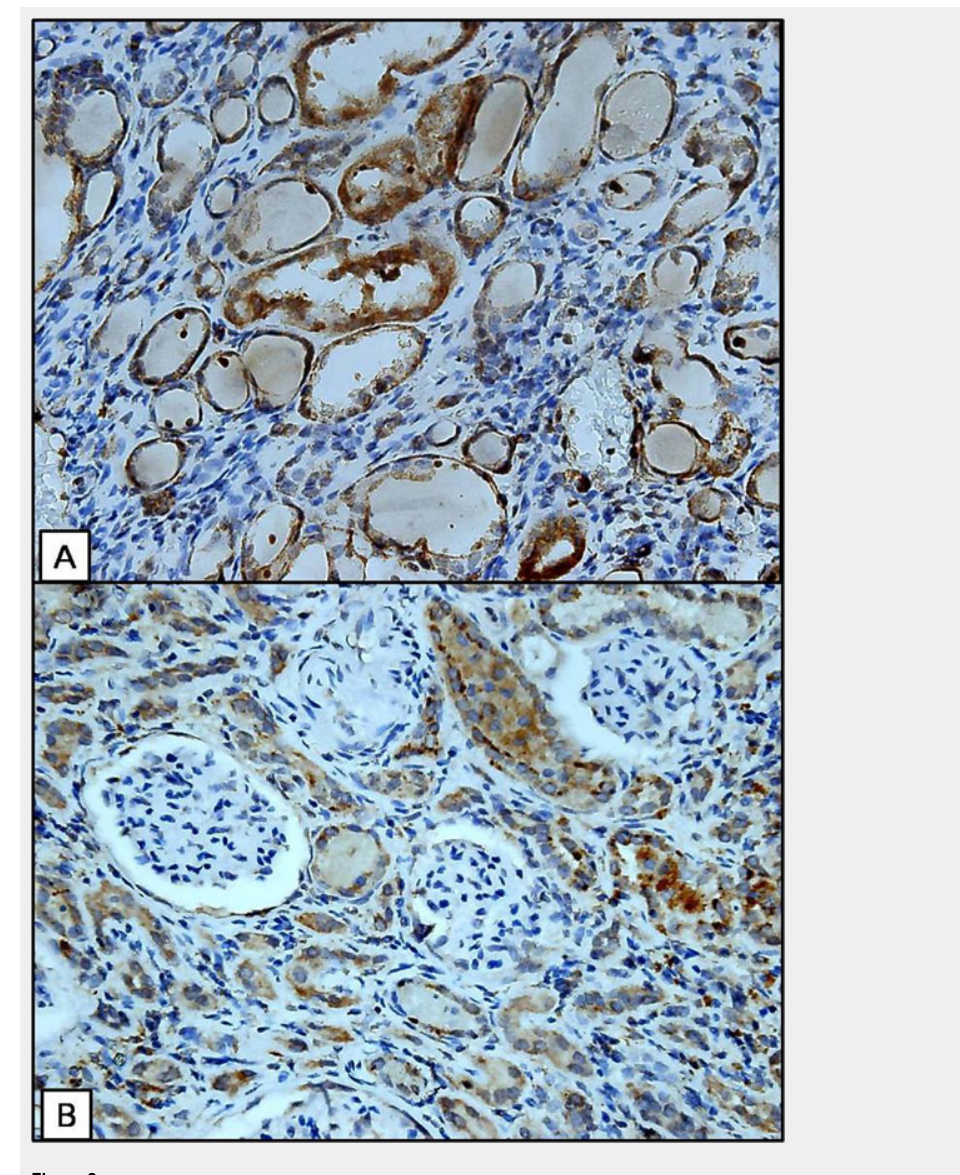
Figure 2 Increased cytoplasmic expression of 8-OHdG in the residual normal tubules in fibrotic renal parenchyma (A) and adjacent to the fibrotic glomeruli (B). (IHC stain,